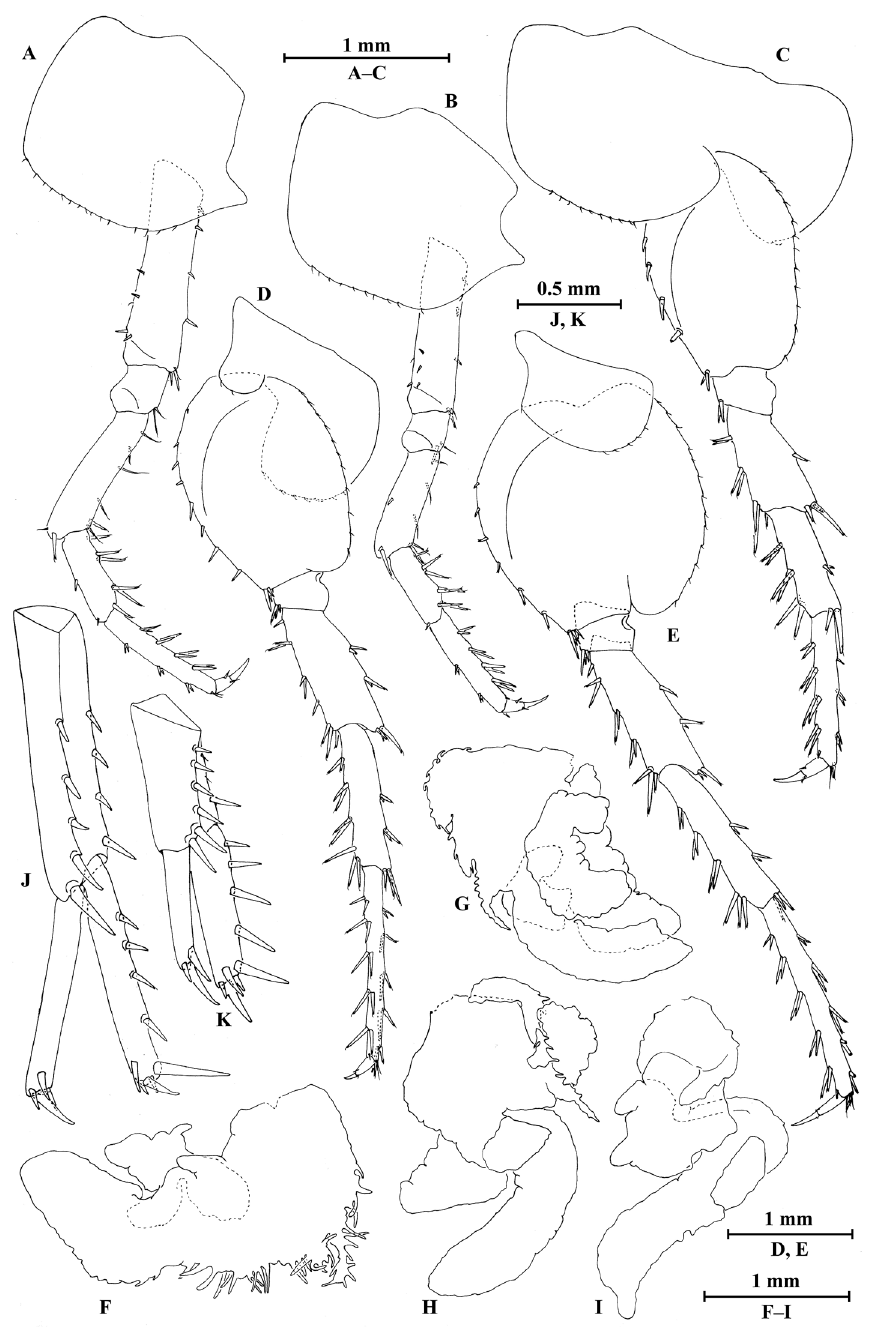
Figure 12. Myanmarorchestia seabri Hou, sp. n., female paratype. A pereopod III B pereopod IV C